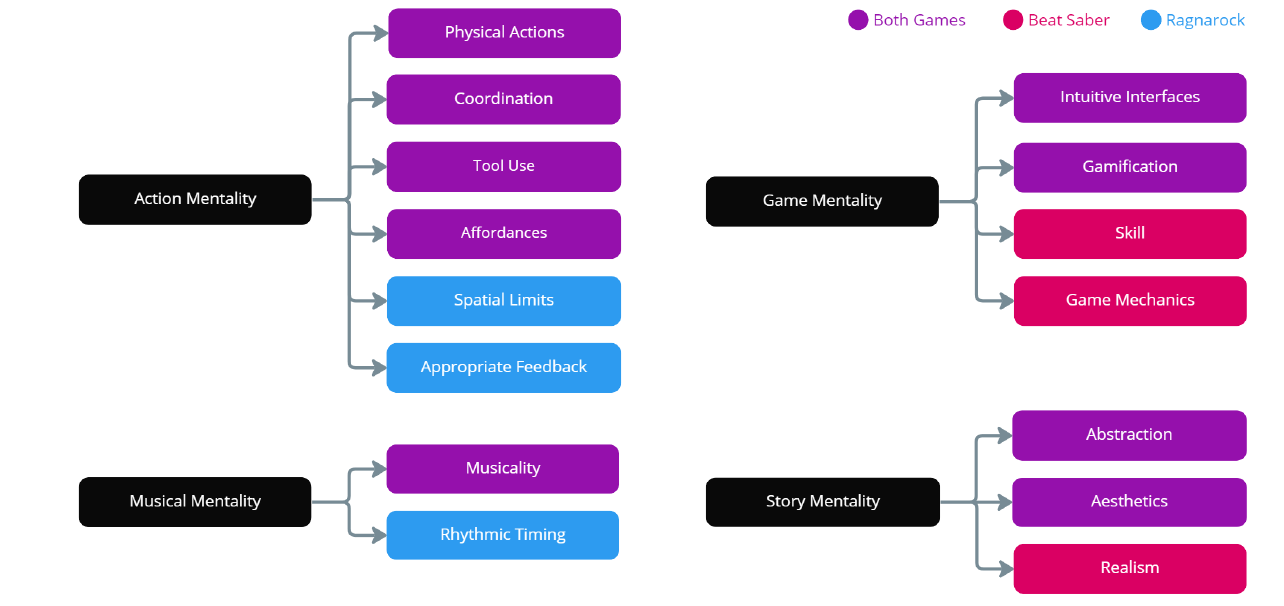
Figure 5. A thematic map indicating the hierarchy between player mentalities and themes from our thematic analysis comparing Beat Saber and Ragnarock. Four mentalities were identified: Action (focus on physical engagement and movement), Game (focus on ability and level completion), Musical (focus on rhythm and beat) and Narrative (focus on the fictional elements of the